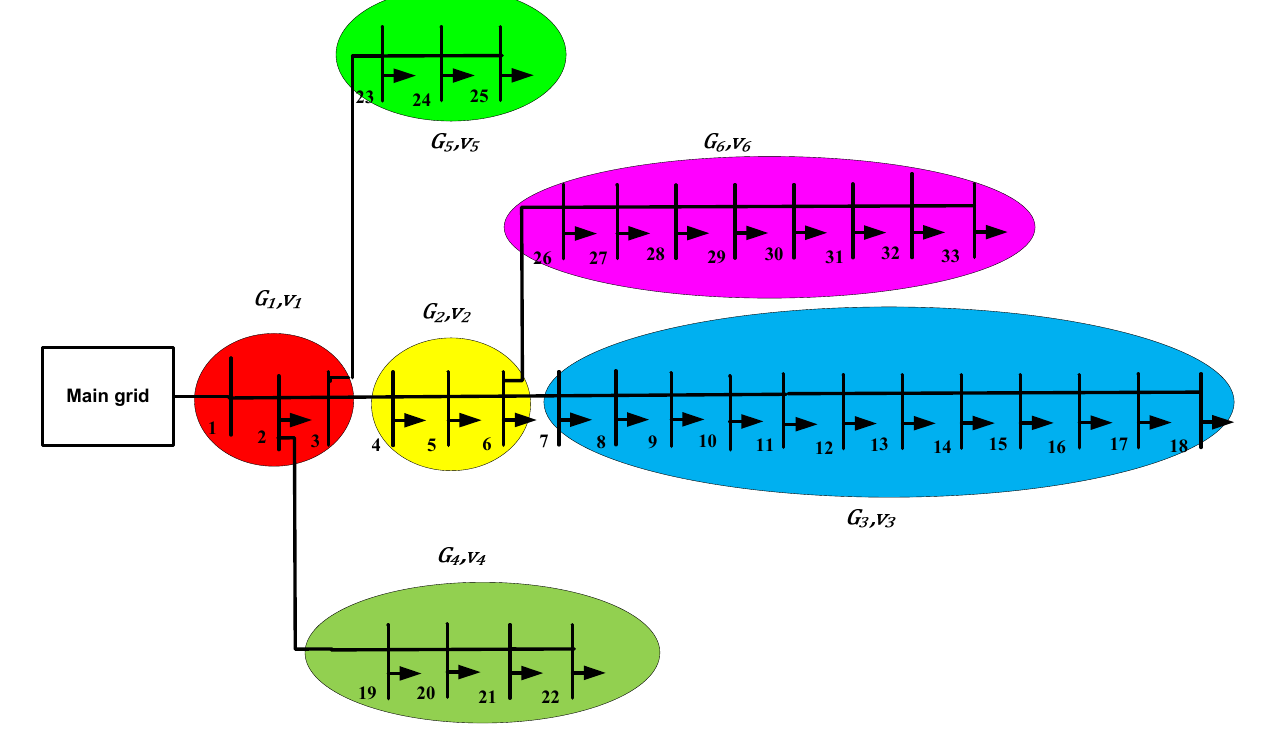
Figure 5. IEEE 33-bus distribution system.